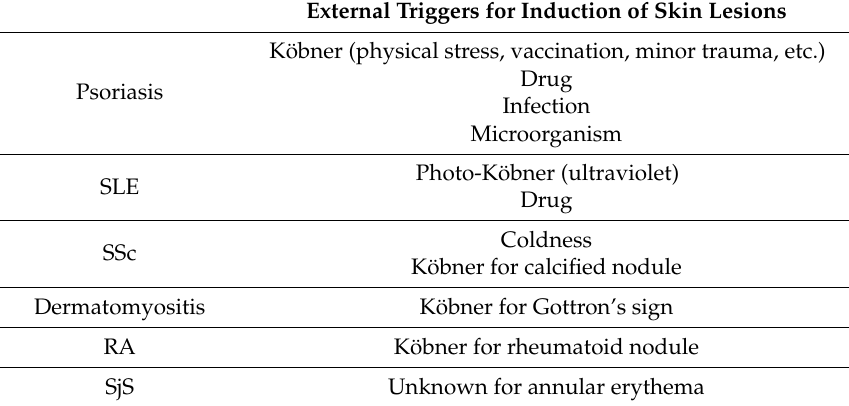
Table 1. Possible precipitating external factors for the induction of skin lesions of psoriasis and connective tissue